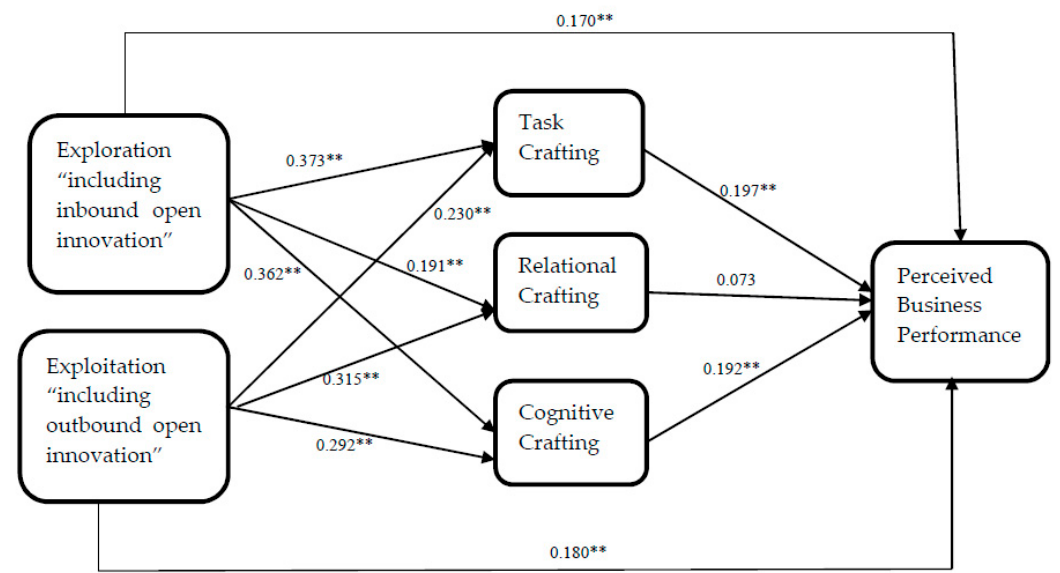
Figure 2. PLS-SEM model. ** p -value significant at < 0.01 level. Table 4. Testing of the multiple mediations structural